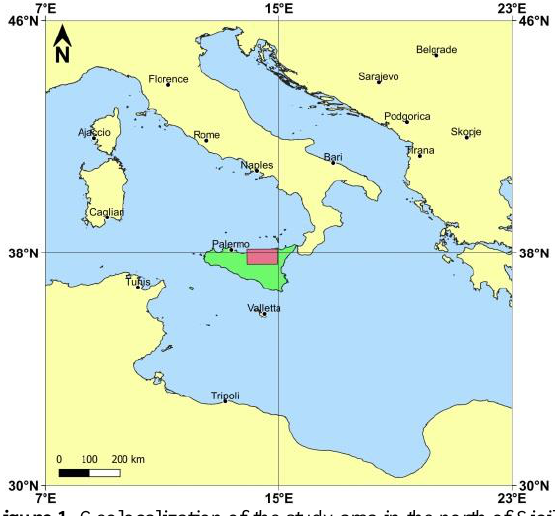
Figure 1. Geolocalization of the study area in the north of Sicily (red rectangle), in equirectangular projection and WGS84 geographic coordinates.